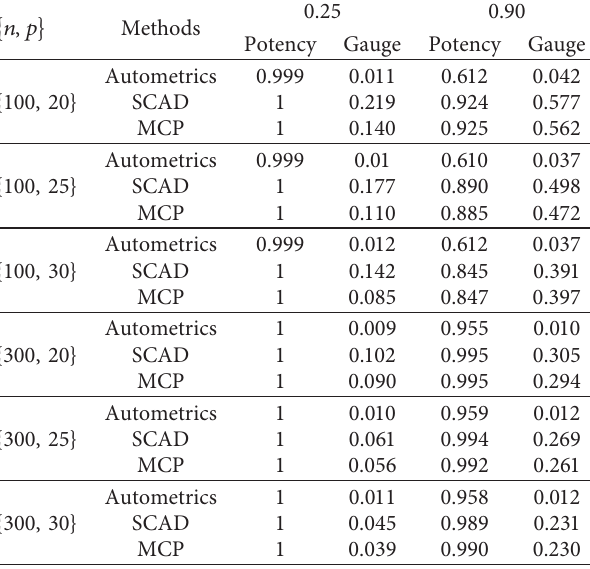
Table 1: Simulation results for exponentially distributed errors.